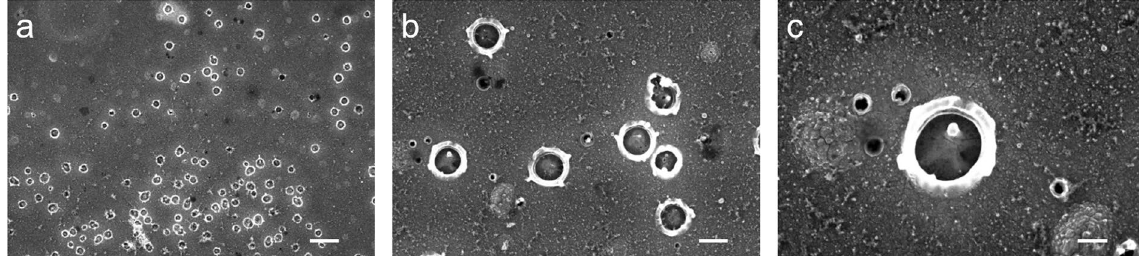
Figure 7. Scanning electron microscope images of the top surface of a test MDM nanocapacitor after a high- voltage breakdown made at ( a ) 5 k magnification, scale bar is 2 μ m, ( b ) 20 k magnification, scale bar is 500 nm, and ( c ) 50 k magnification, scale bar is 200